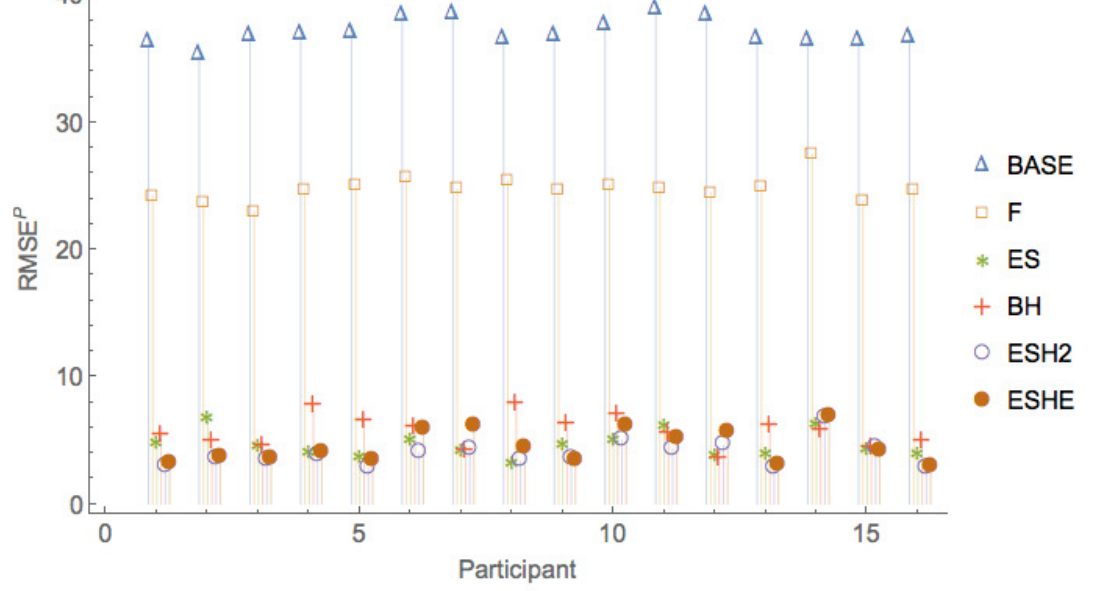
Figure 5. Comparison of leave-one-period-out LOOCV RMSE of all models for Session